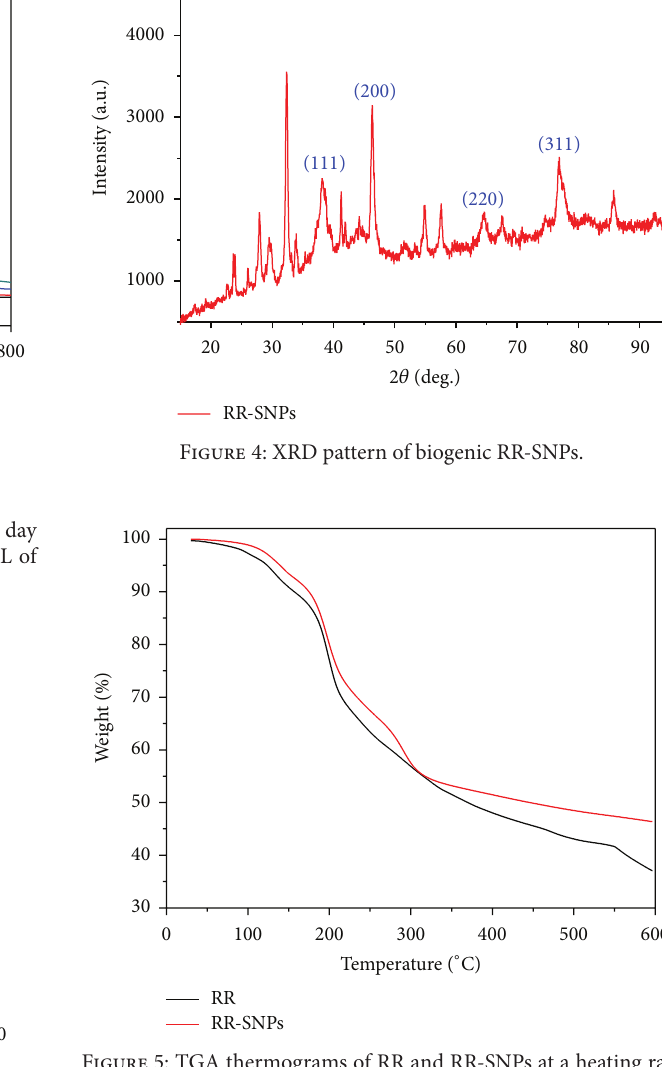
Figure 5: TGA thermograms of RR and RR-SNPs at a heating rate of 10 ∘ C/min under N 2